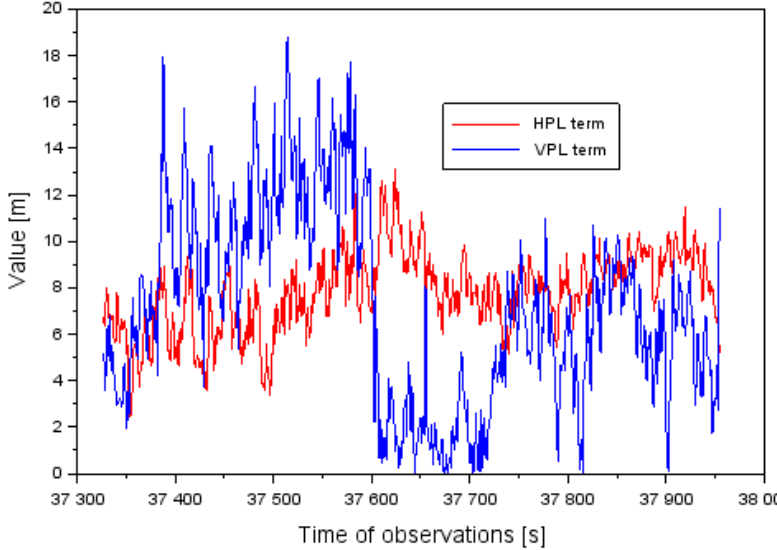
Figure 3. The HPL (Horizontal Protection Level) and VPL (Vertical Protection Level) values in the air test in D ę blin.